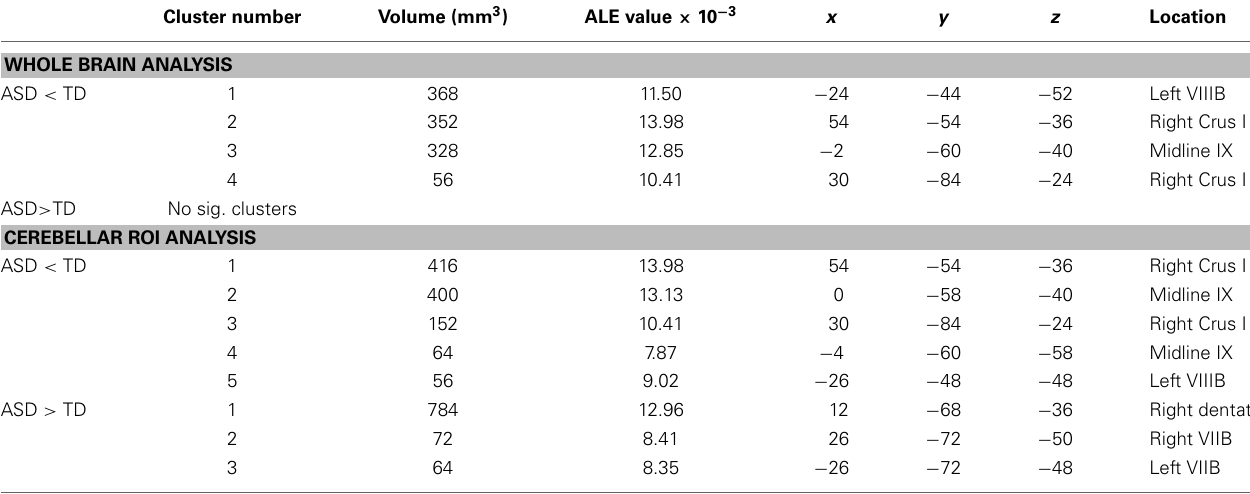
Table 3 | GM differences in ASD: whole brain and cerebellar-only analyses.